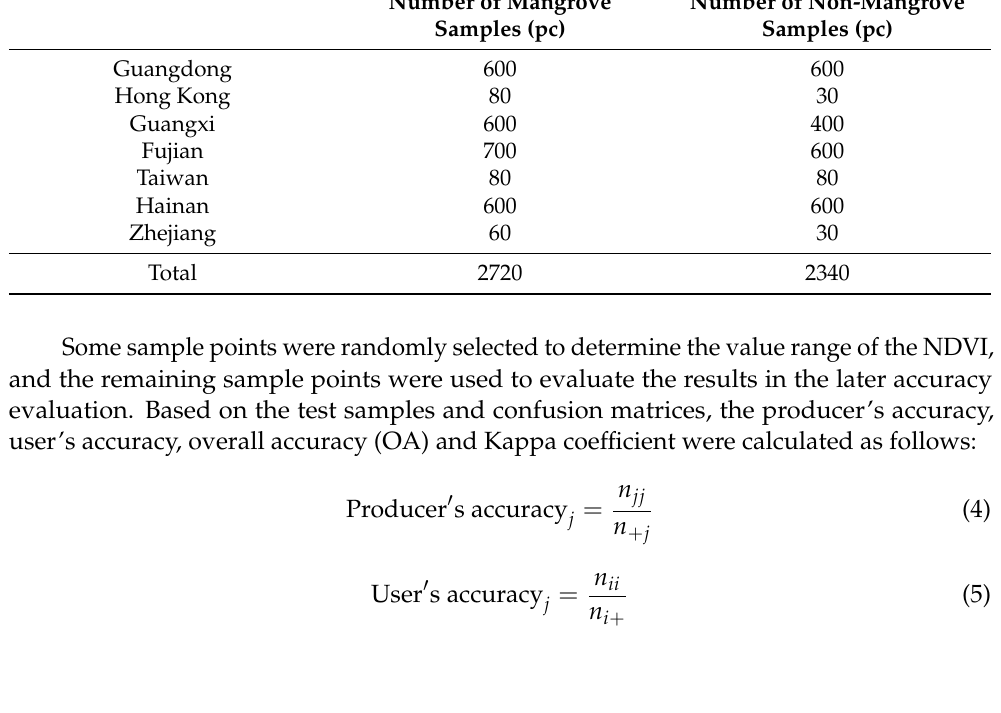
Number of Mangrove Number of Samples (pc)